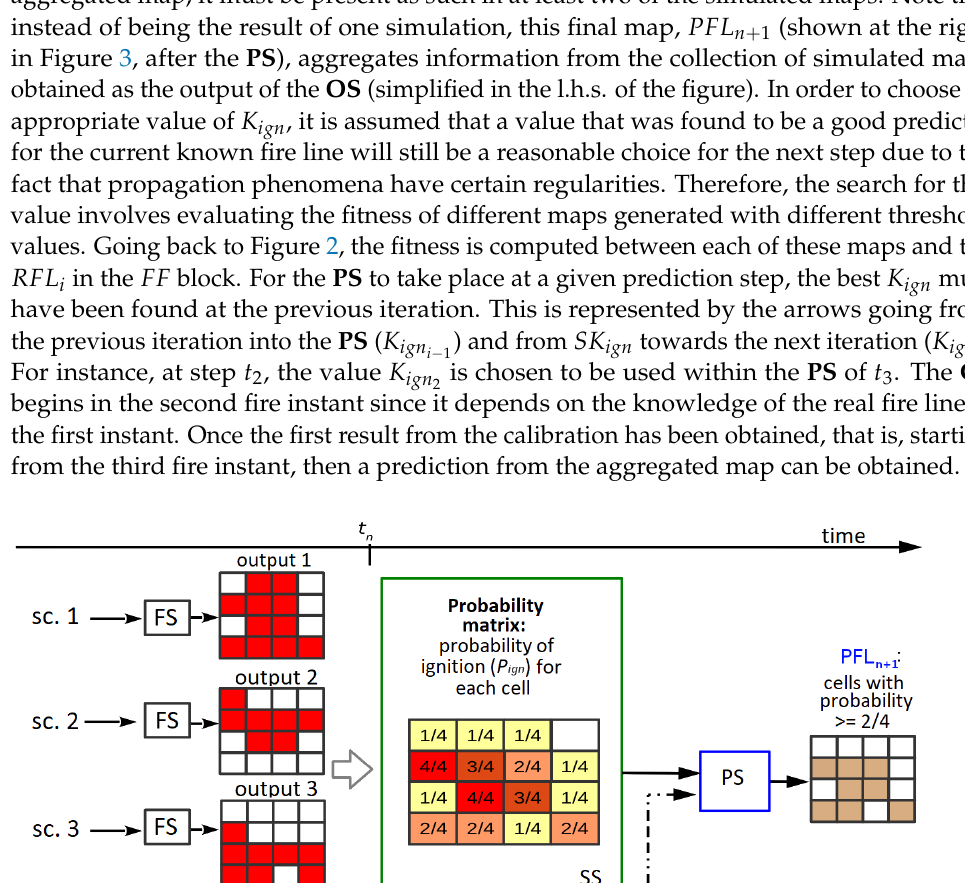
Figure 3. Generation of the prediction. sc. : scenario; FS : fire simulator,; SS : Statistical Stage; K ign Key Ignition Value computed for instant t n ; PS : Prediction Stage; PFL n + 1 : predicted fire line for t n + 1